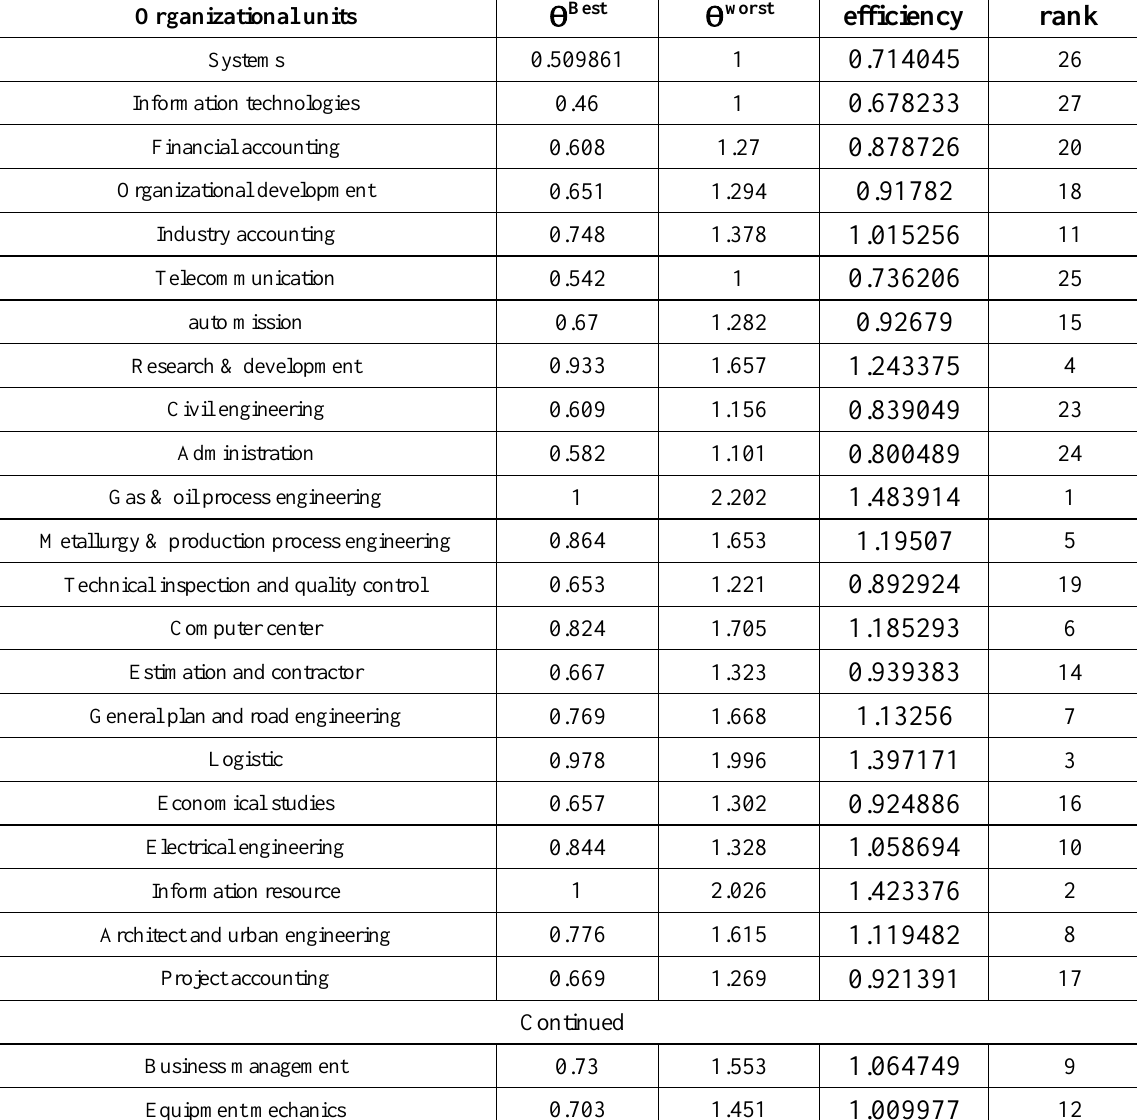
Table5. Ranking of units Organizational